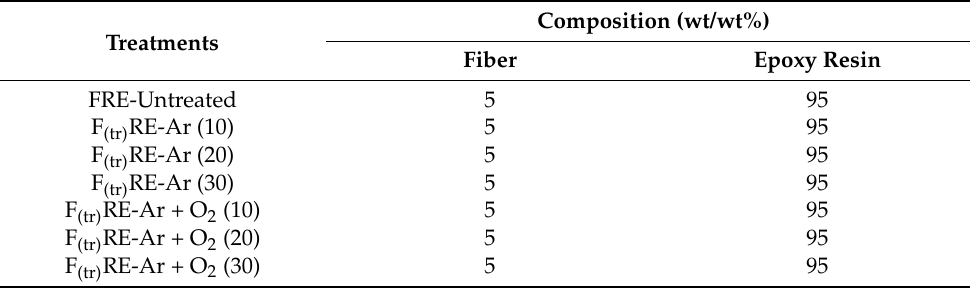
Table 2. The labels and composition of the FRE resin composite samples.